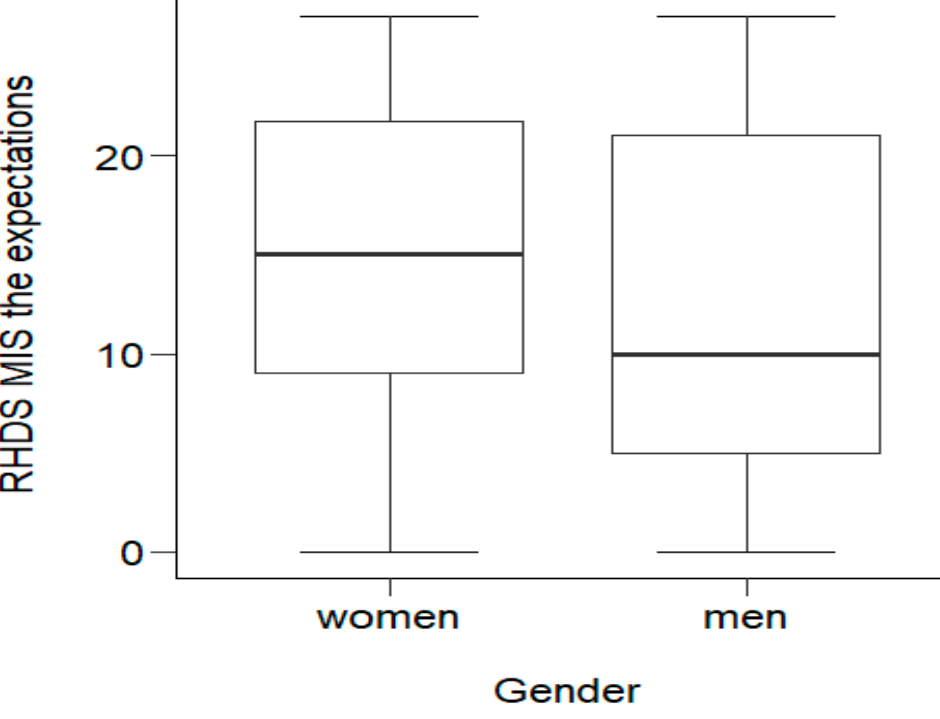
Figure 2. Effects of socio-demographic variables on MI patients’ expectationsof the disease.